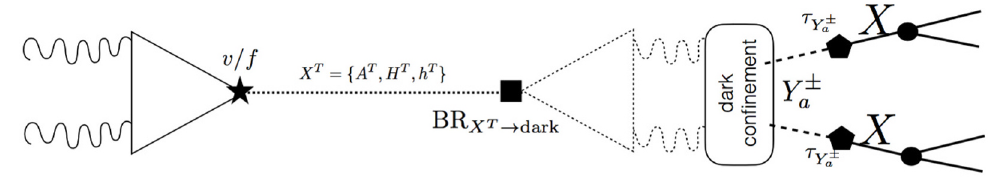
Figure 11 . Cartoon of the production and decay of LLPs through heavy Twin Higgs